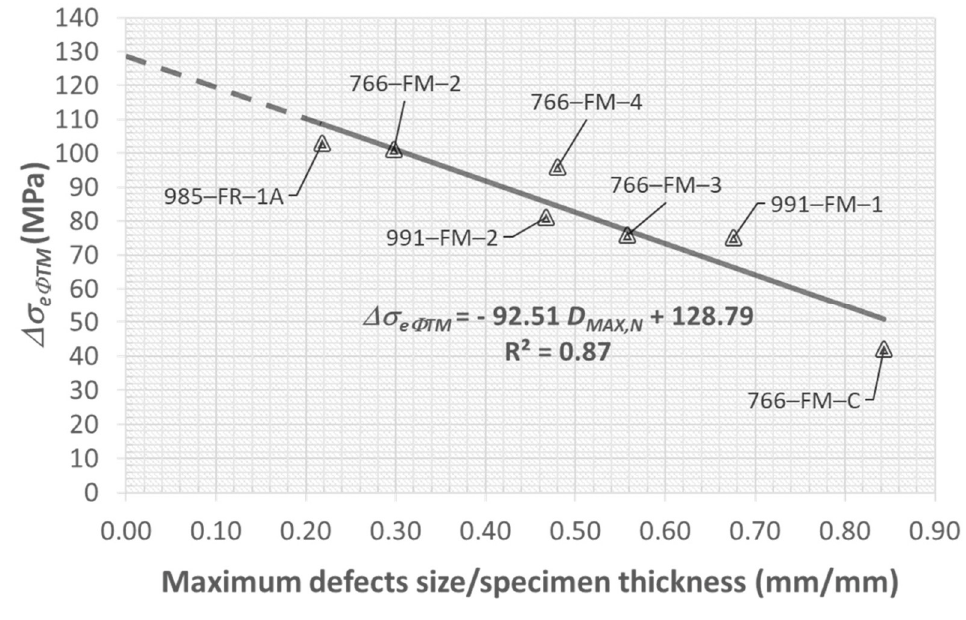
Figure 22. Fatigue strength (Δσ eΦTM ) vs. normalized maximum defect size (D MAX,N ) [128].